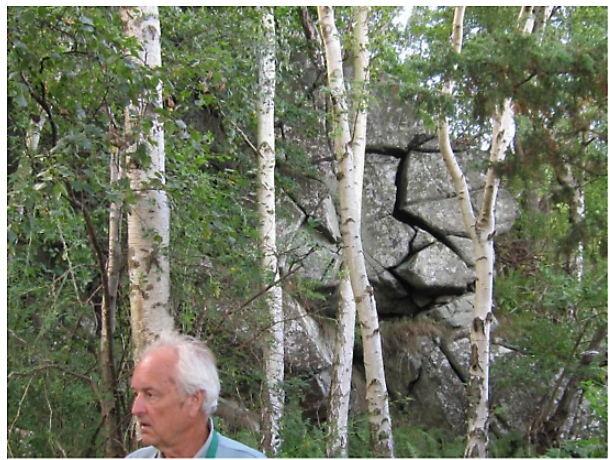
Fig. 7. Bedrock cliffs strongly fractured and moved by shaking or weather changes. Nils-Axel Mörner explaining the phenomenon. Photo by Soren